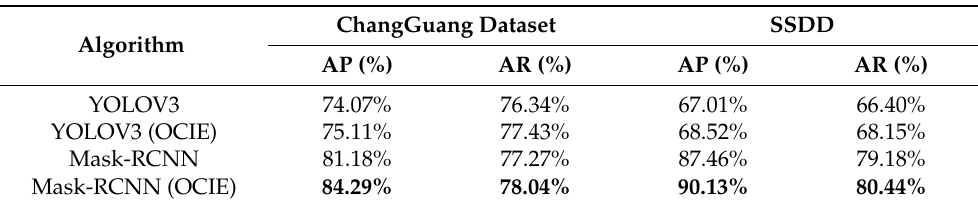
Table 1. Experimental results of the object characteristic-driven image enhancement (OCIE) module on the ChangGuang dataset and SSDD.